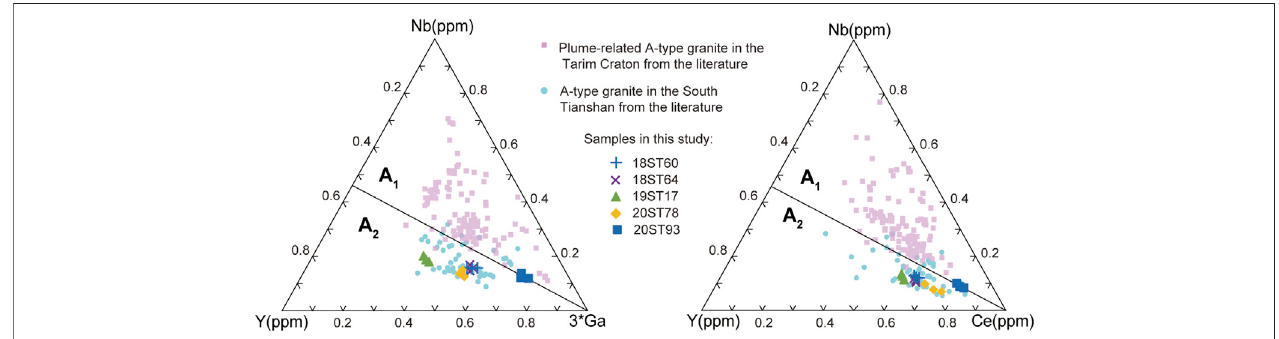
FIGURE 12 | Discrimination diagrams (after Eby, 1992) showing the dominant A 2 -subtype af fi nity of the A-type granitoids in the South Tianshan (literature data sources: Konopelko et al., 2007, 2009; Huang et al., 2015a; Long et al., 2008; Wang et al., 2007b), which is signi fi cantly different from the plume-related A 1 -subtype af fi nity of the granites in the Tarim craton (data sources: Huang et al., 2012; Su et al., 2019; Wei et al., 2019; Wei and Xu, 2011; Yang et al., 2007; Zhang et al., 2008).